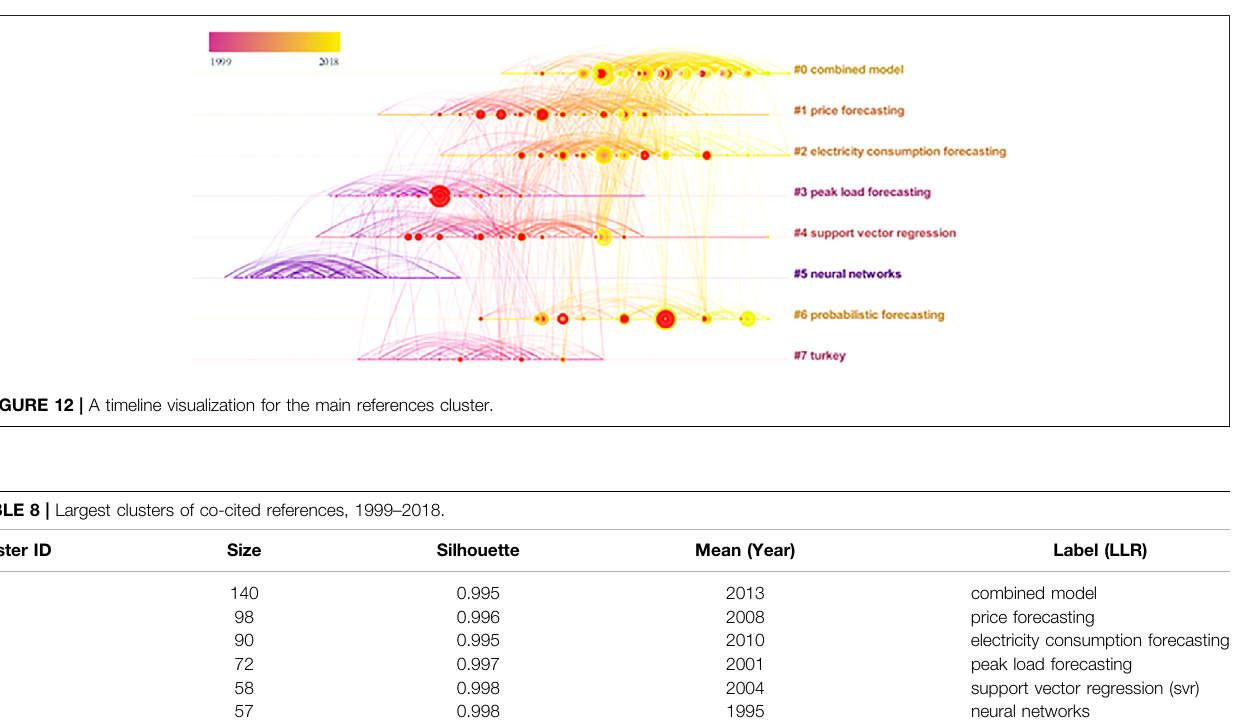
Figure 11 . Figure 12 is a line graph of the co-citation of the literature, similar to the keyword timeline. It shows the time evolution process of the six clusters. From the results, the earliest cluster is neural networks, and it ’ s also the same as the keyword timeline visualization results, which illustrates the importance of neural networks in this fi eld. The combined model is the largest cluster, which has been continuously